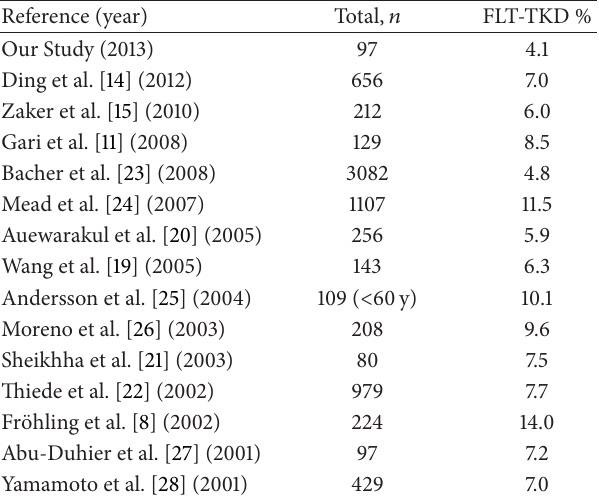
Table 3: Frequency of FLT3 /TKD mutations in the current study and in previous